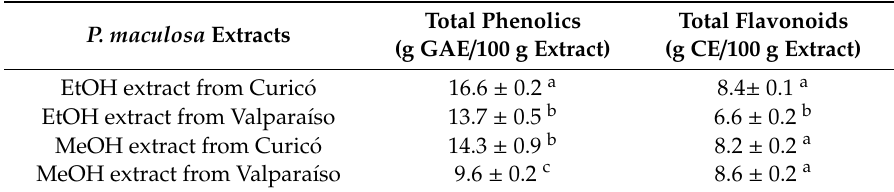
Table 1. Total phenolics and total flavonoids of Persicaria maculosa extracts ( N = 3 / extract) * .